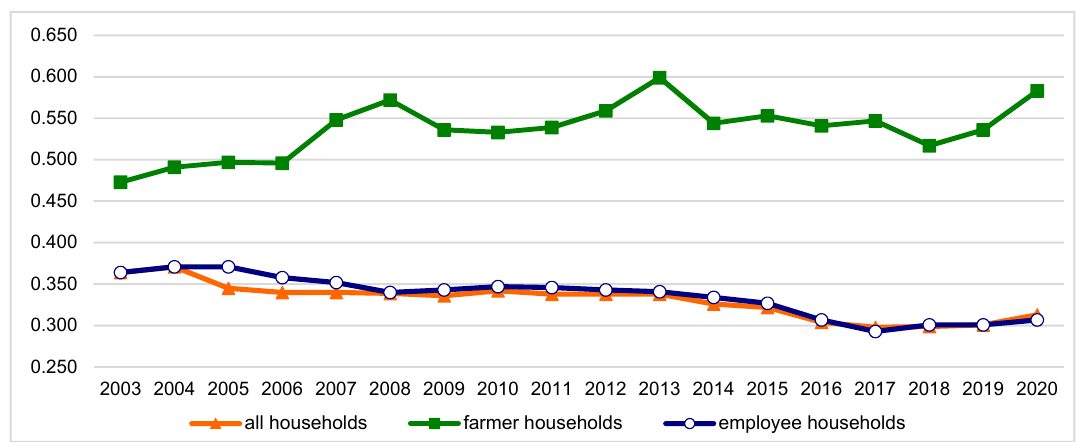
Figure 4. Differences in available income per capita measured by the Gini coefficient in Poland in 2003–2020 for selected groups of households. Source: as Figure 1.